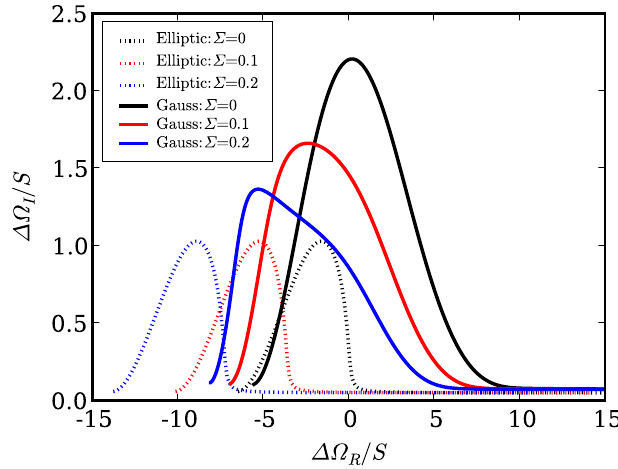
FIG. 5. (Color) Stability boundaries from Eq. (28) as a function of the normalized coherent frequency shifts for different space charge parameters in a double rf wave. The bunch length of the equivalent Gaussian and elliptic distributions is (cid:1)